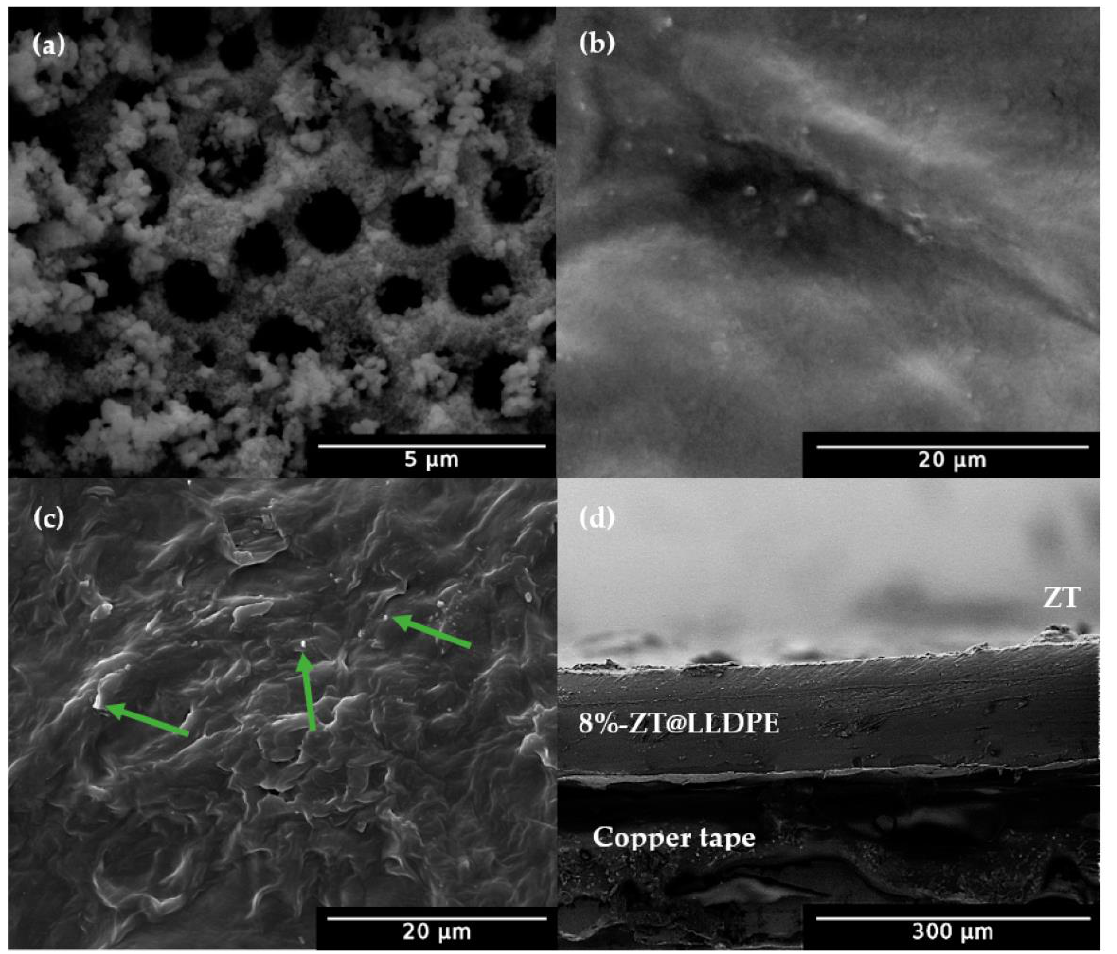
Figure 10. FESEM images of ( a ) ZT, ( b ) neat LLDPE, ( c ) 8%-ZT@LLDPE, and ( d ) cross-section of the 8%-ZT@LLDPE nanocomposite positioned on the film without any visible microcracks or voids. Green arrows indicate white spots representing ZnO QDs. Reprinted from [58].